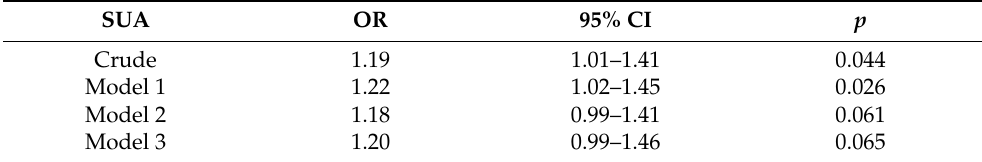
Table 3. Association between serum uric acid concentration and rapid progression of renal